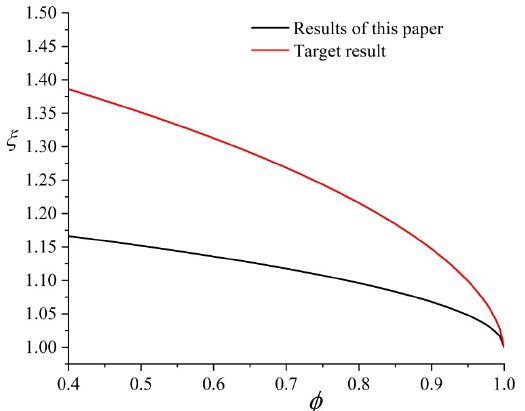
Figure 5. Comparison of the proposed model of tortuosity with previously published [22] results— lower limit arrangement.